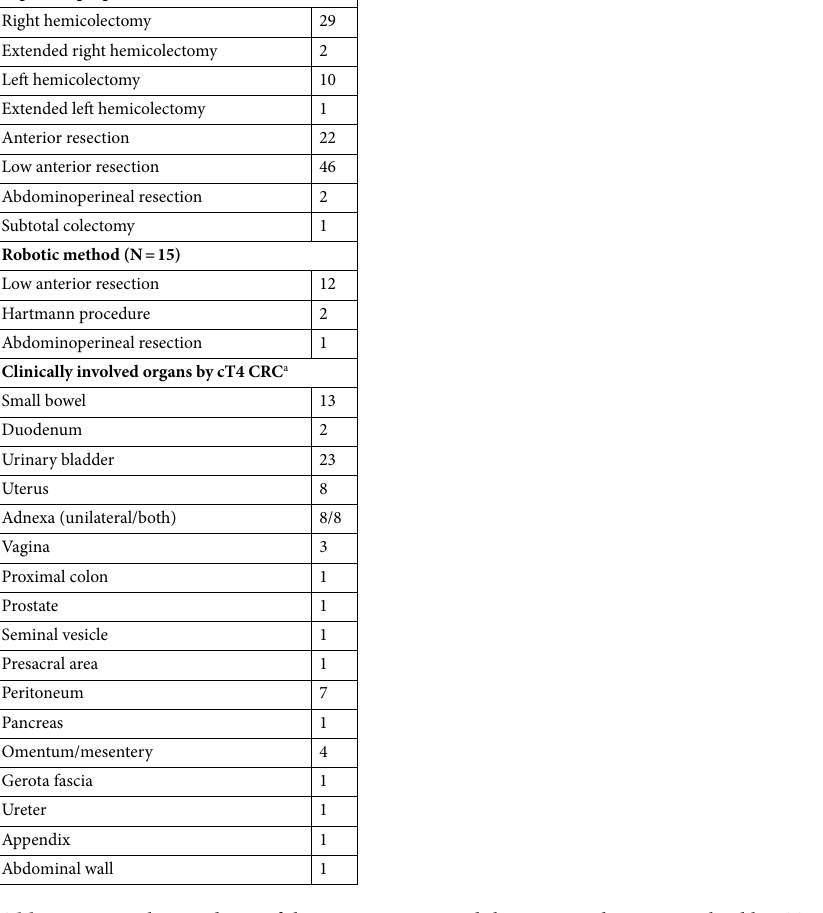
Table 2. Surgical procedures of the primary CRC and the suspected organ involved by cT4 CRC undergoing the synchronous resection (N = 128). a A patient might have more than one organ